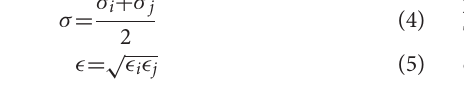
x-direction wall, the +